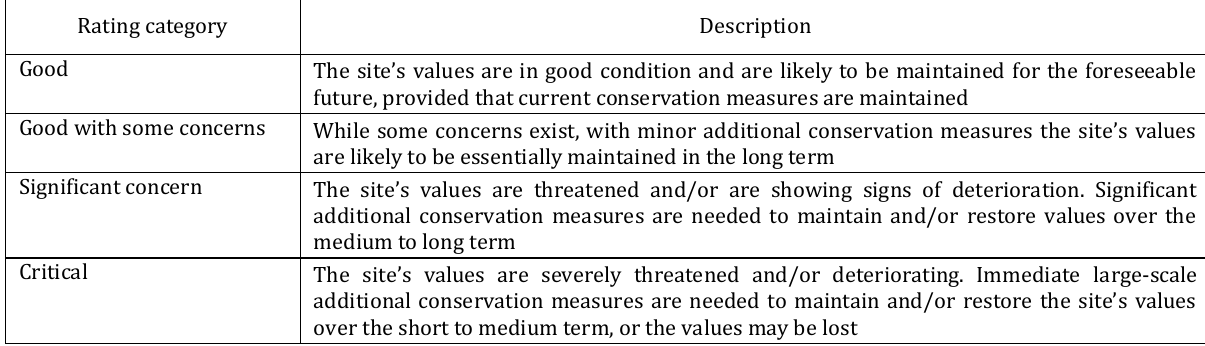
Table 2. Rating categories for Conservation Outlook Assessments (Source: Osipova et al.,